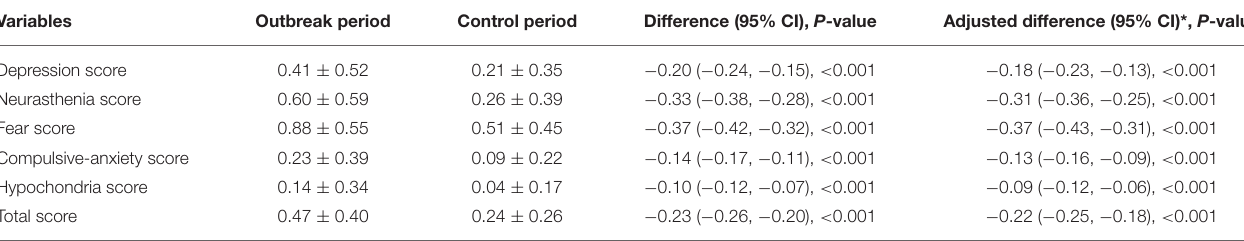
TABLE 3 | Changes in psychological questionnaire scores between the outbreak period and the control period.